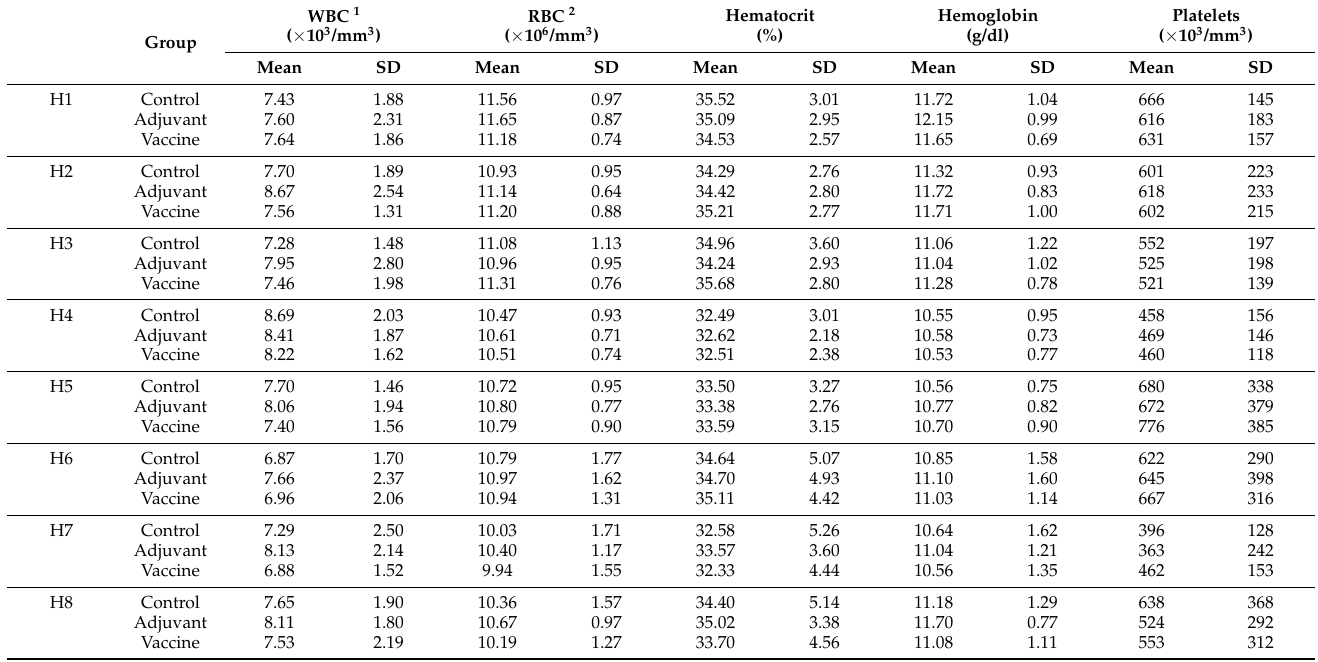
Table A14. Hematological results along the experiment in Control, Adjuvant-only, and Vaccine groups ( n = 26 each) of all Flocks grouped together. Data represented as mean and standard deviation (SD). H: Hematology date. A reference threshold is provided at the end of the